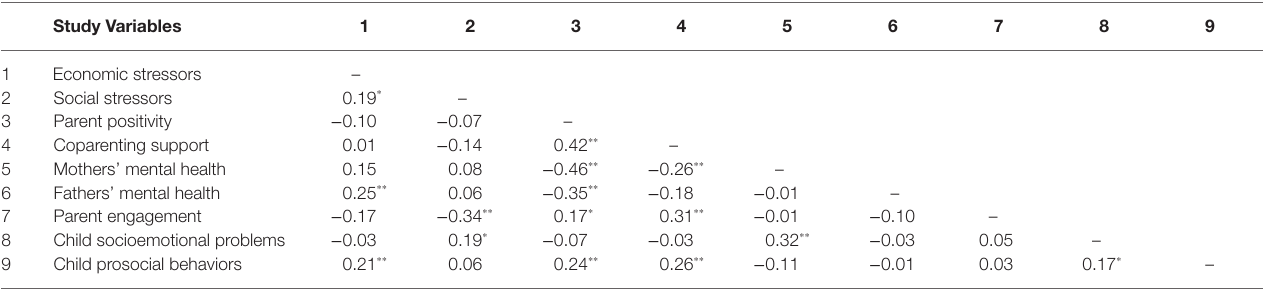
TABLE 3 | Zero-order Correlations for All study Variables Aggregated except for Parental Mental Health. Study